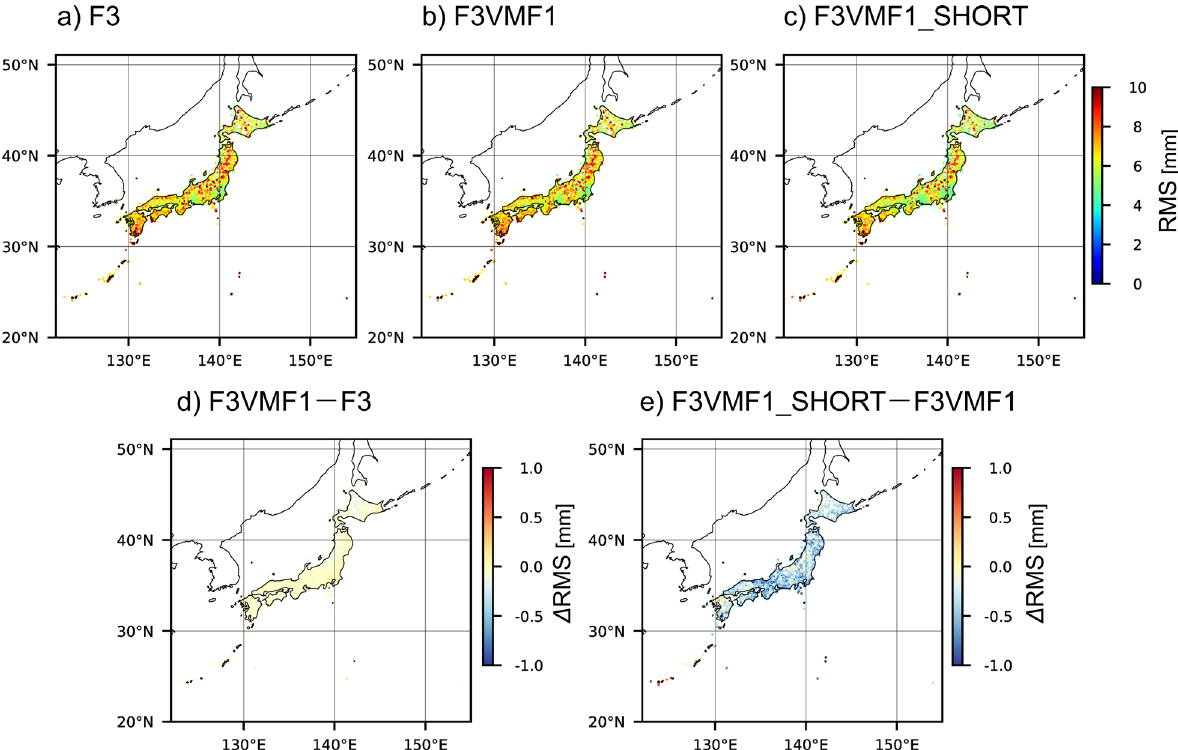
Fig. 10 Distribution of RMS for the UD component in a F3, b F3VMF1 and c F3VMF1_SHORT and their difference ( d F3VMF1 minus F3 and e F3VMF1_SHORT minus